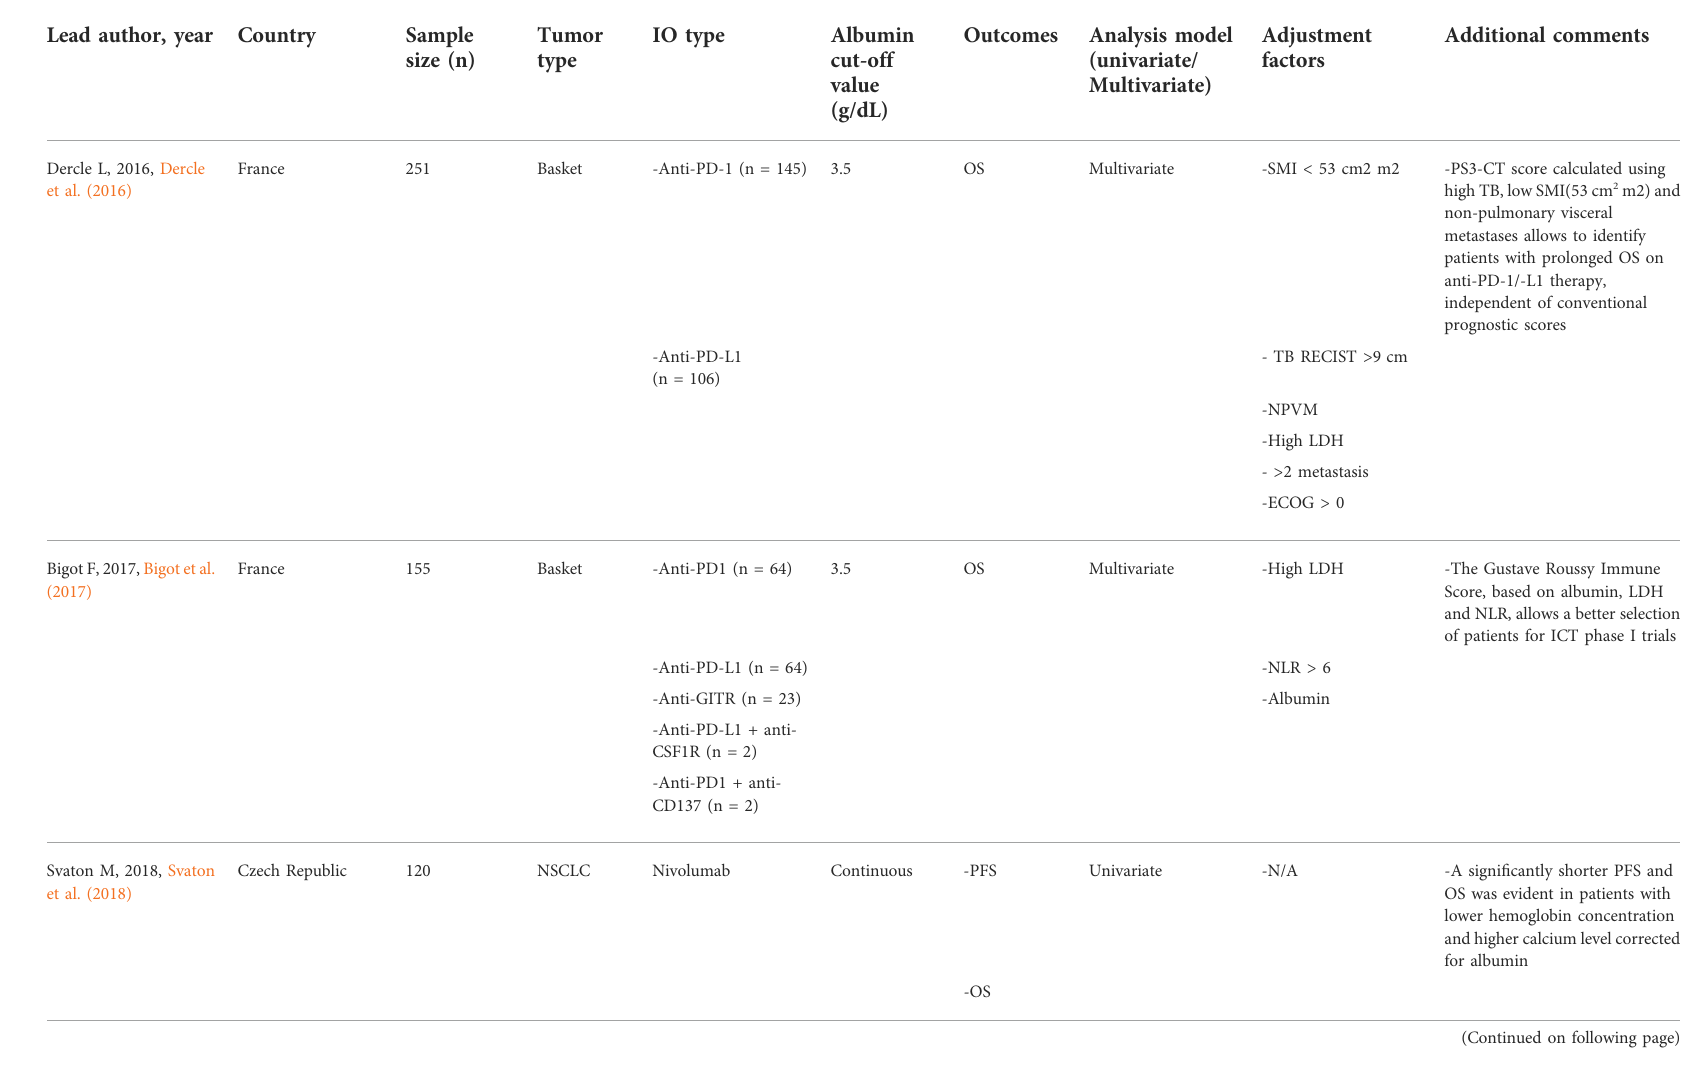
TABLE 1 Baseline characteristics of included